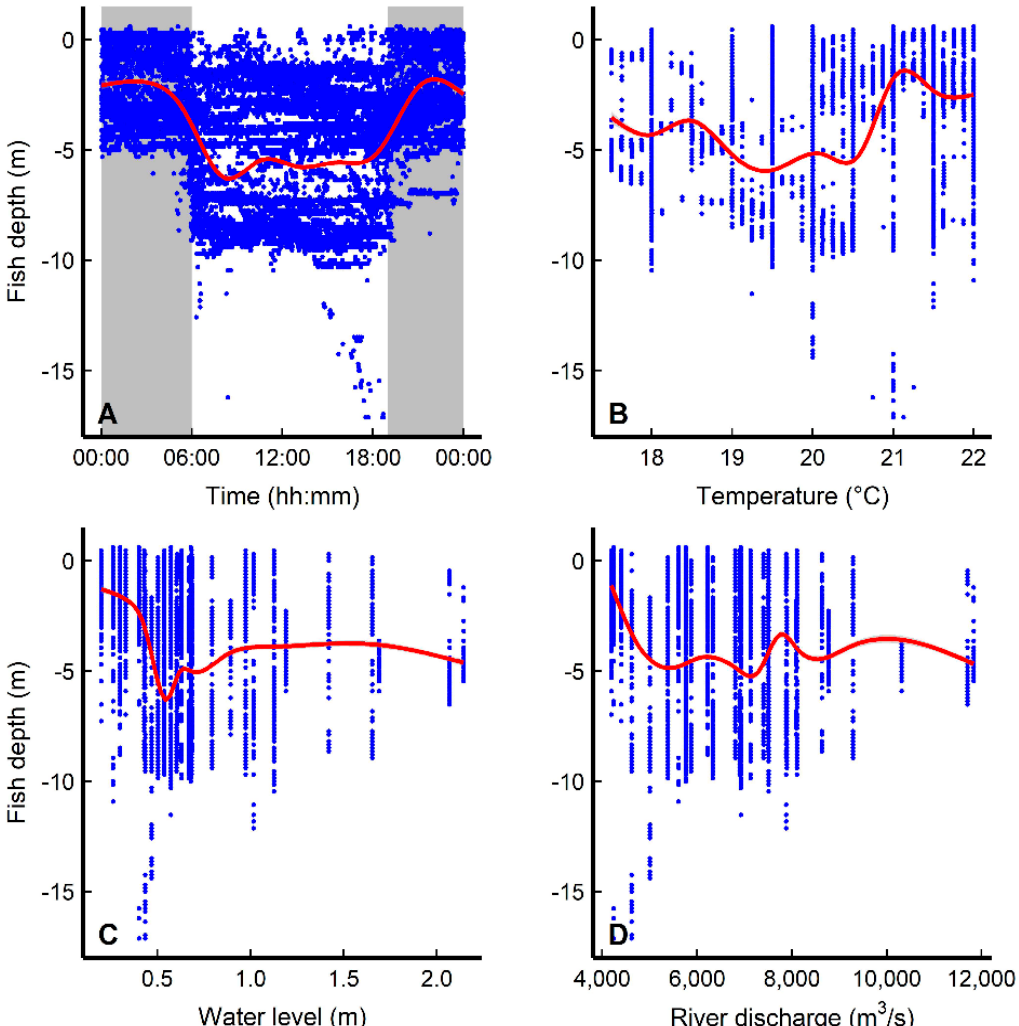
Figure 6. Effects of diel phase, temperature, water level, and river discharge on common carp depth. A smoothing (gam) curve with a span width of 0.5 was added for visual interpretation.